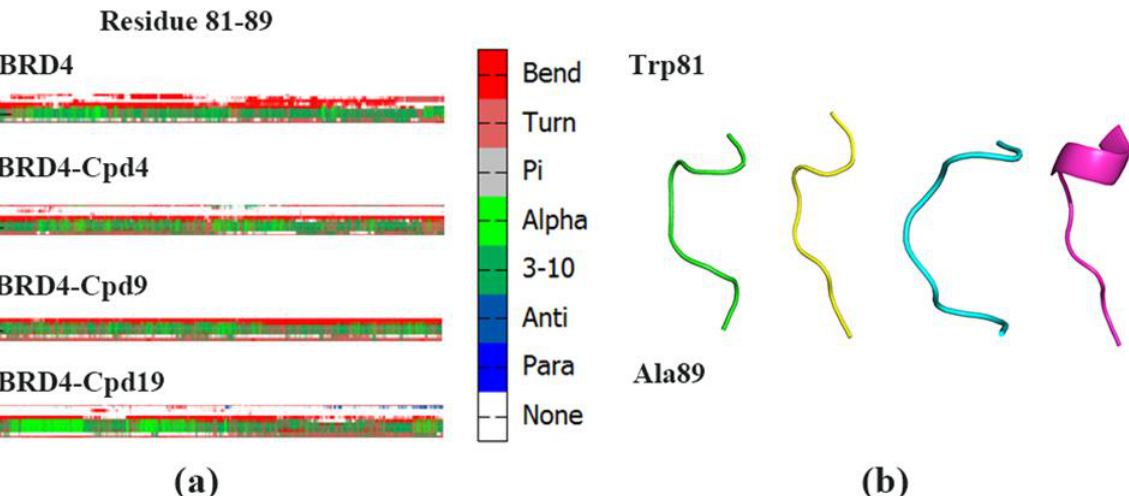
Figure 5. ( a ) Differences in the secondary structures of residues Trp81 to Ala89 of the four systems ( b ) Structure of Trp81 to Ala89.